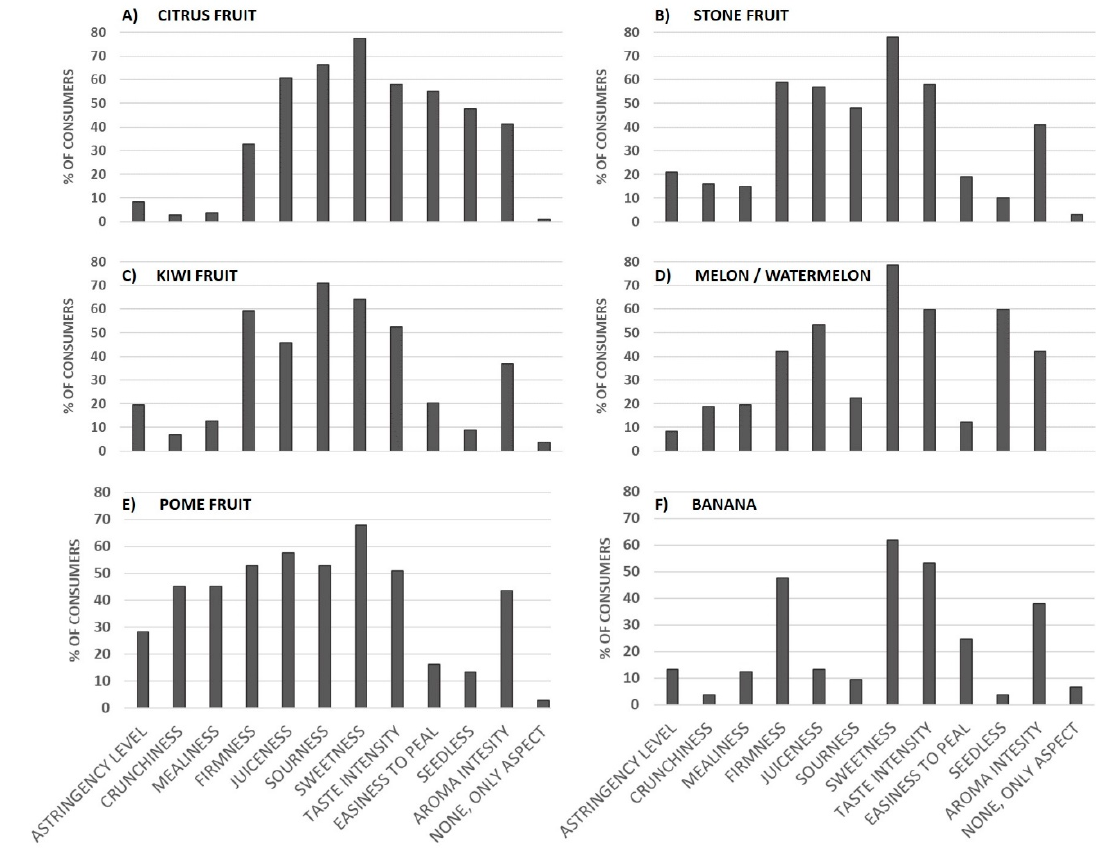
Figure 2. Sensory label content depending on the fruit type: ( A ) citrus fruit; ( B ) stone fruit; ( C ) kiwi fruit; ( D ) melon/ watermelon; ( E ) pome fruit; ( F ) banana. Percentage of consumers (among those interested in receiving information and who normally purchase packaged fruit) who declared being interested in acquiring information about different sensory attributes for several fruit types.